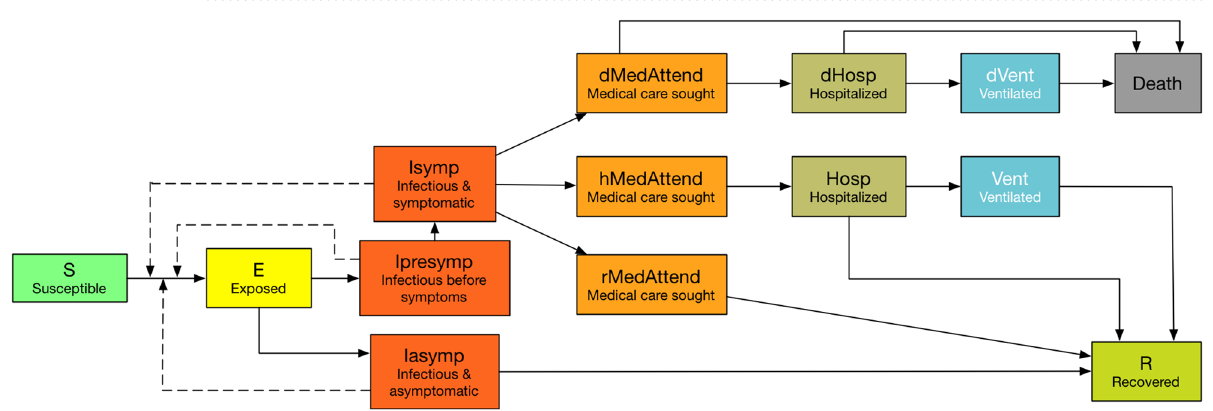
Figure 1. This figure shows the overall modeling framework, its various components and their linkages.